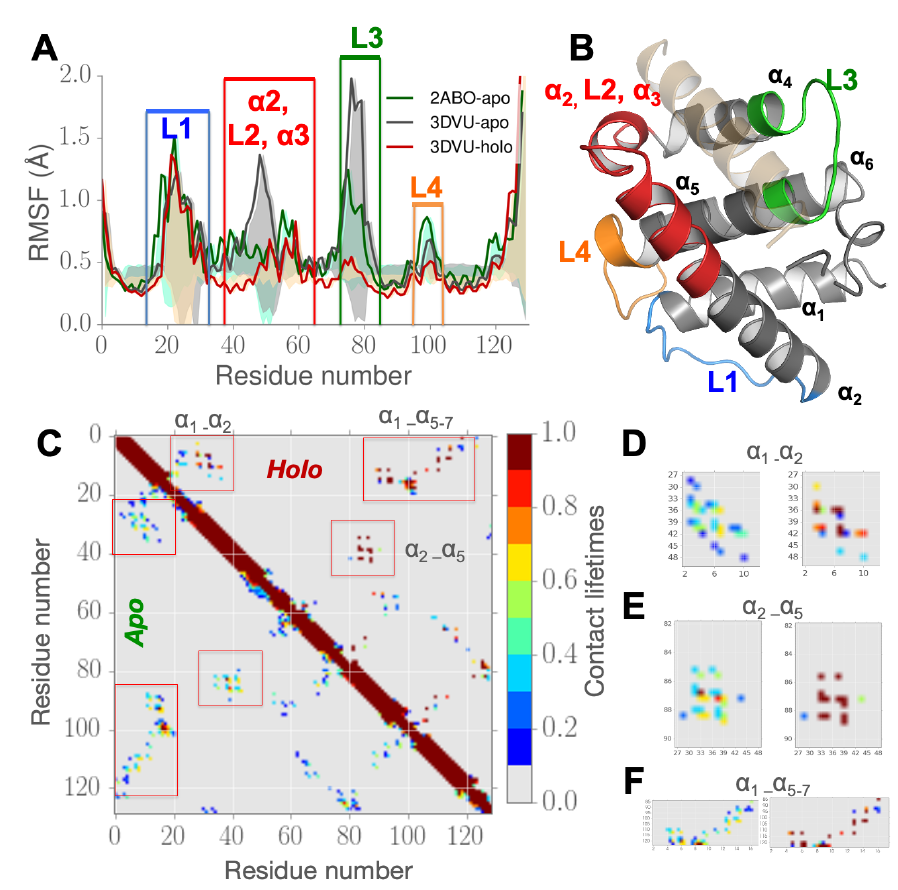
Figure 2. RMSFs and contact re-arrangements from microsecond long MD simulations in vBCL2 within apo- and holo-M11 simulations show partial unfolding and refolding of α 2 . ( A ) RMSF plots for the apo-M11 simulations (2ABO-apo shown in green solid line and 3DVU-apo shown in gray solid line) and holo-M11 simulations (initated from 3DVU structure; red solid line) showing RMSF values plotted per residue (at the corresponding C α atoms). ( B ) Four regions that show significant differences in RMSF upon binding in ( A ) are highlighted on the 3DVU-holo structure. The bound BH3 domain (BECN1 from 3DVU structure) is highlighted in orange transparent cartoon. ( C ) Lifetime of contacts between the apo (lower triangle) and holo (upper triangle) to demonstrate the contrast in fluctuations between the two states, and to understand the conformational changes after BH3D binding. A higher lifetime indicates higher stability and lower lifetime indicates no contact or less stable interactions. ( D ) Distinct areas of changes between apo- and holo- states calculated from the simulations can be observed across highlighted rectangles, which are zoomed in an inset for residues lining ( D ) α 1 (6–18) and α 2 (28–48); ( E ) α 2 and α 5 (88–98); and, ( F ) α 1 , α 5 − 7 (90–110). Our simulations posit a significant increase in the stability of long-lived contacts after BECN1 BH3D binding, especially across regions farther away from the binding